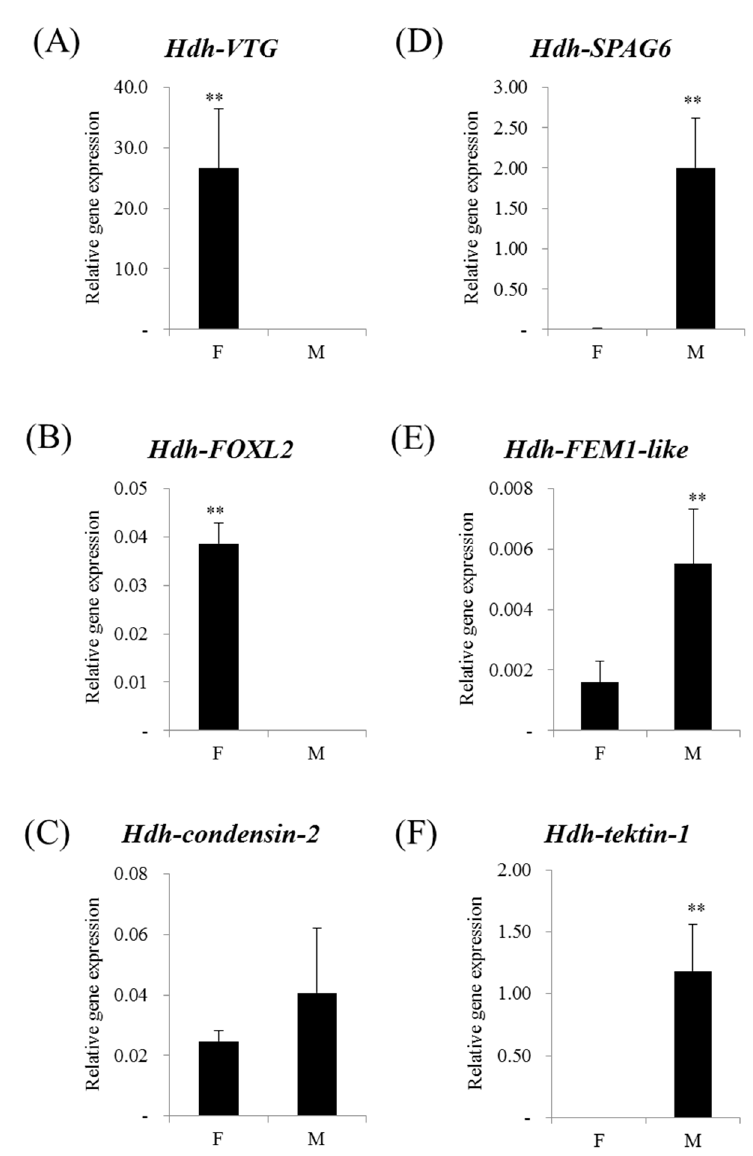
Figure 6. Relative mRNA expression profiles of the six selected genes from sexually mature Haliotis discus hannai by quantitative real-time RT-PCR analysis. The genes overexpressed in females were vitellogenin ( Hdh-VTG ) ( A ) and forkhead box protein L2 ( Hdh-FOXL2 ) ( B ), but not condensin-2 ( Hdh-condensin-2 ) ( C ). The genes overexpressed in males were sperm-associated antigen 6 ( Hdh-SPAG6 ) ( D ), protein fem-1 homolog C-like ( Hdh-FEM1-like ) ( E ), and tektin-1 ( Hdh-tektin-1 ) ( F ). Statistical changes were determined by the Student’s t test (two-tailed) and are denoted as follows: ** p < 0.01. M and F indicate female and male, respectively.